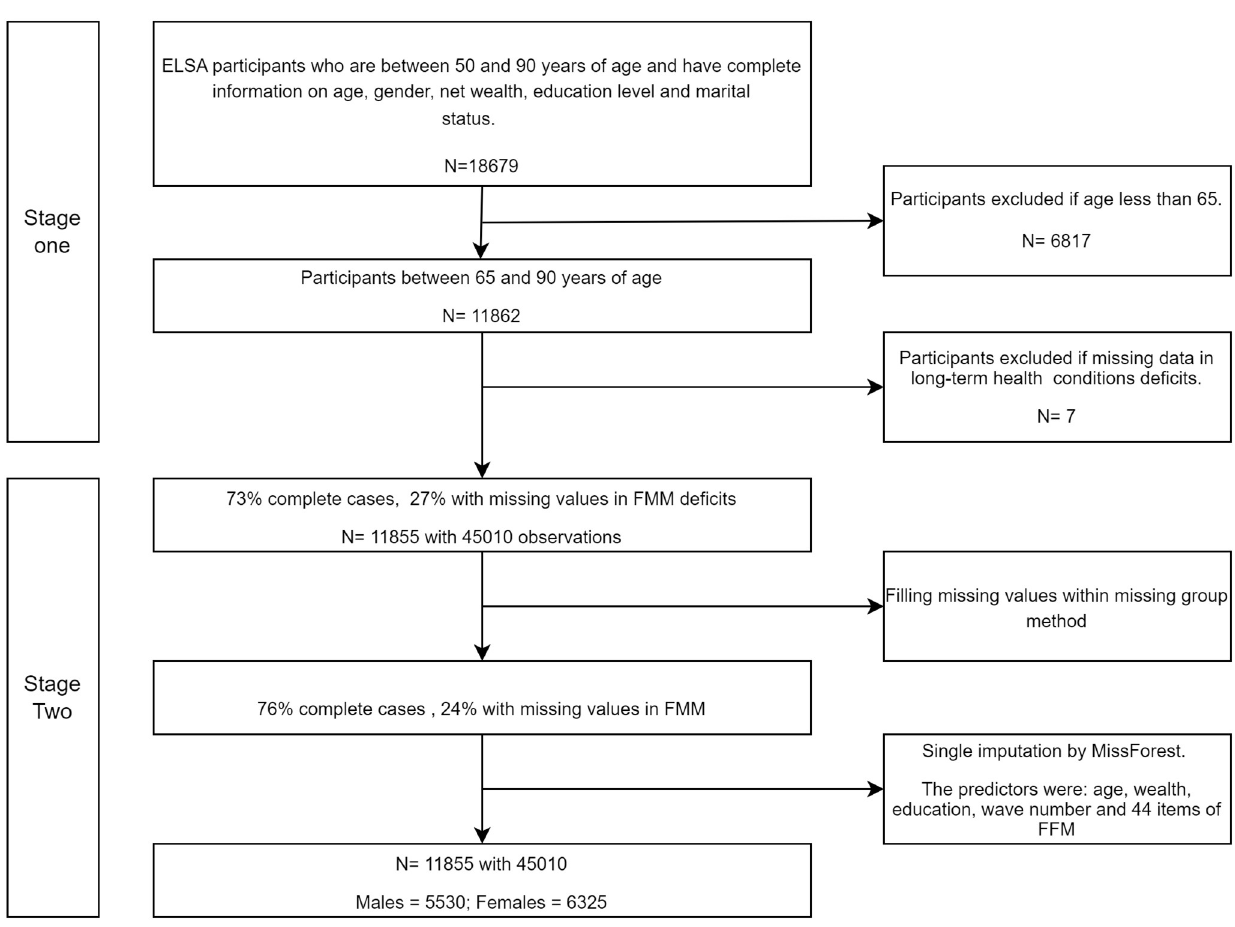
Fig 1. The flowchart for the analytical sample + handled missing